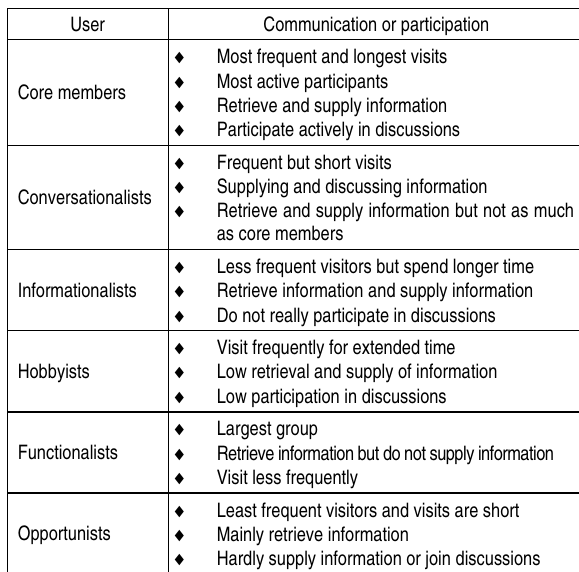
Table 1. Social media user